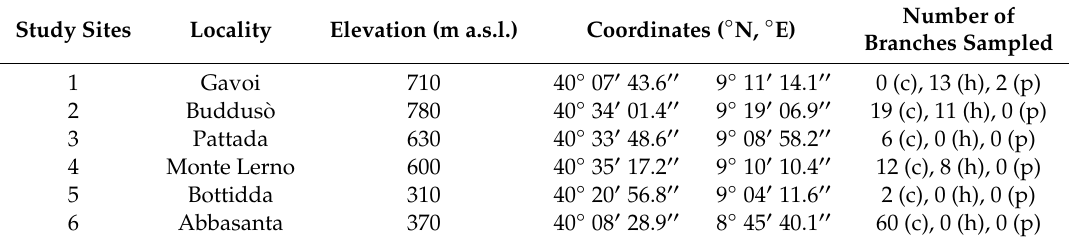
Table 1. Study sites information and number of symptomatic branch samples collected from cork oak (c), holm oak (h), and pubescent oak (p)